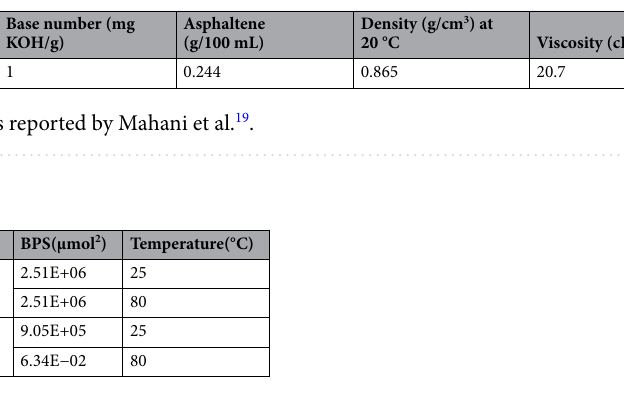
Table 9. The calculated BPS of rock samples of Mahani et al. 19 at different temperatures.